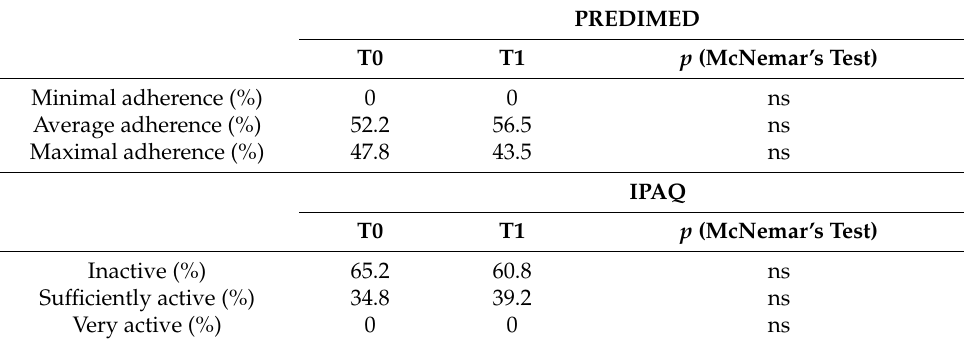
Table 9. PREDIMED and IPAQ questionnaires of study